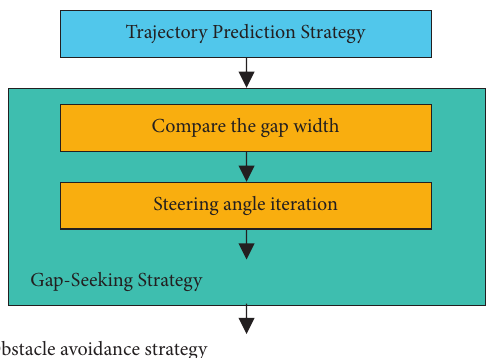
Figure 10: The envelope region formed by the trajectory line.